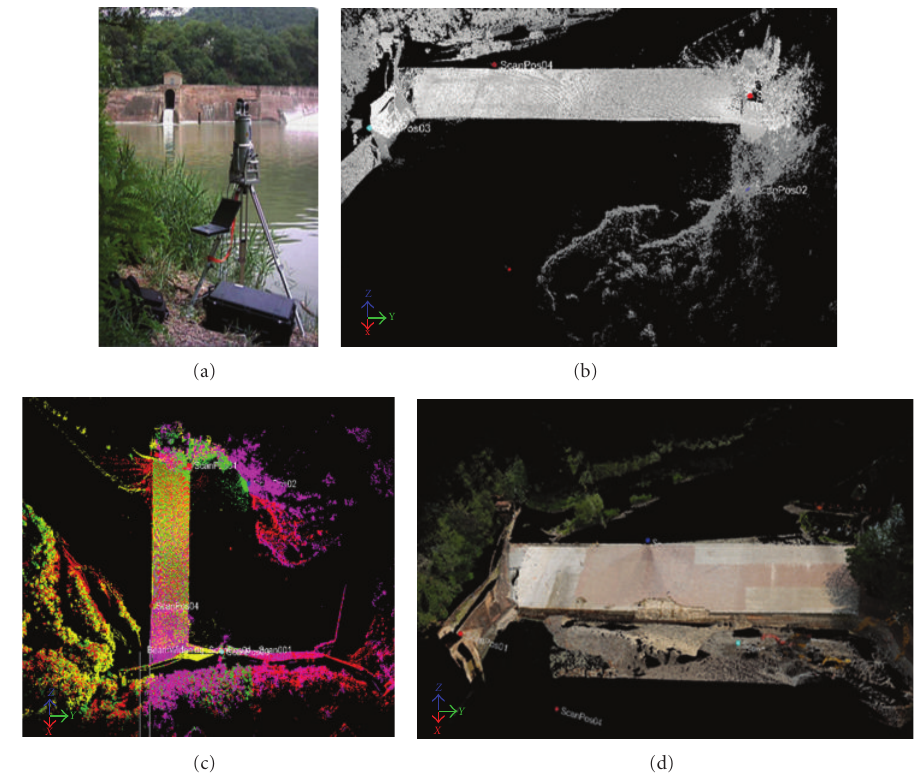
Figure 6: Terrestrial laser scanning surveys and digital photogrammetry: (a) Riegl LMSZ420i coupled with Nikon D200 digital camera; (b, c) laser scanning points clouds of the sluice and the surrounding area (2006); (d) the 3D raster model of the chute after the great damages su ff ered by the structure during the 2008-2009 winter.